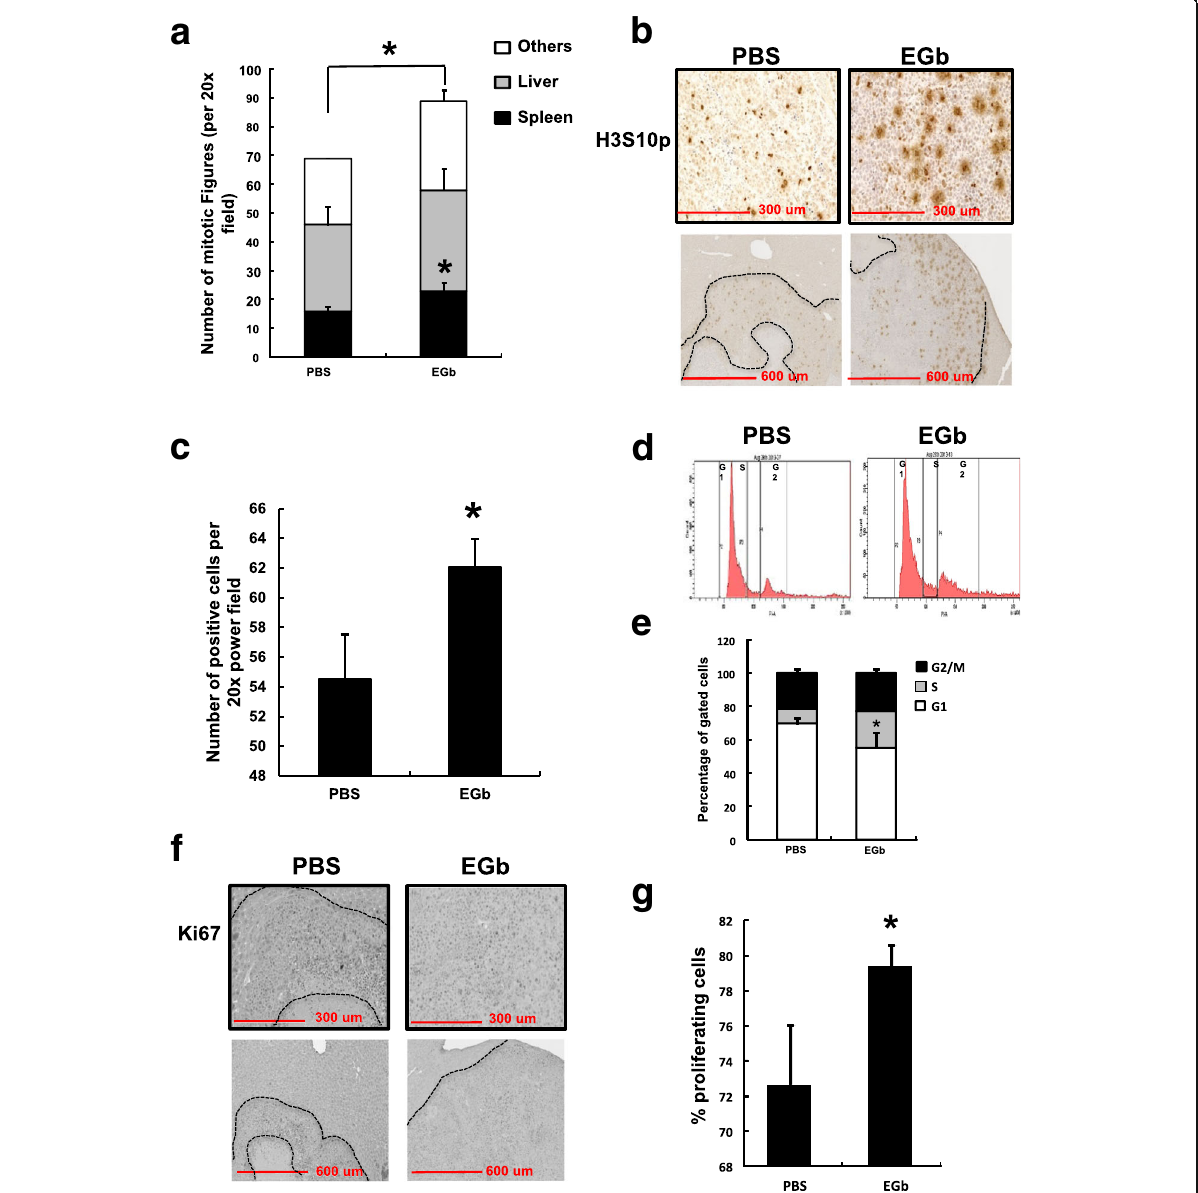
Fig. 2 Mitosis and cell cycle in metastatic tissues. a Mitosis in the spleen, liver and other sites in mice with metastatic tumors. Black bars: numbers of mitotic figures in spleen, gray bars: numbers of mitotic figures in liver, open bars: numbers of mitotic figures in other abdominal tissues including skin and smooth muscle, adipose and mesentery lymph node. Y-axis is the number of mitotic figures per 20× power field. b Immunohistochemical staining of phosphorylated histone H3 serine 10 (H3S10p) in the metastatic liver. The upper panels show 20× power field and the lower panels show 10× power field of cross-sectioned mouse liver. The dotted lines outline tumor area without necrosis. c Quantification of H3S10p staining in the metastatic liver. Y-axis represents the number of positive cells per 20X power field. d Cell cycle analysis in mouse liver with metastasis. X-axis represents the signal intensity by PI staining and Y-axis indicates the total cells count. e Quantification of cell cycle analysis. Y-axis represents the percentage of gated cells (%). Open bars: % of cells in G0/G1 phase, grey bars: % of cells in the S phase, black bars: % of cells in the G2/M phase. f Immunohistochemical staining of Ki67 in the metastatic liver. The upper panels show 20× power field and the lower panels show 10× power field of cross-sectioned mouse liver. The dotted lines outline tumor area without necrosis. g Quantification of Ki67 staining in the metastatic liver. Y-axis represents the percentage of proliferating cells (%). Asterisks (*) indicate statistical significance ( n >4, p < 0.05) compared to PBS phosphorylated p38 (p-p38), phosphorylated p44/42 stress-activated protein kinases (JNK), ERK/big MAP (p-p42/44) and phosphorylated JNK (p-JNK) in the kinase 1 (p44/42), and the p38 group of protein kinases Tumor group when compared to the PBS control (p38). EGb significantly increased hepatic protein level of